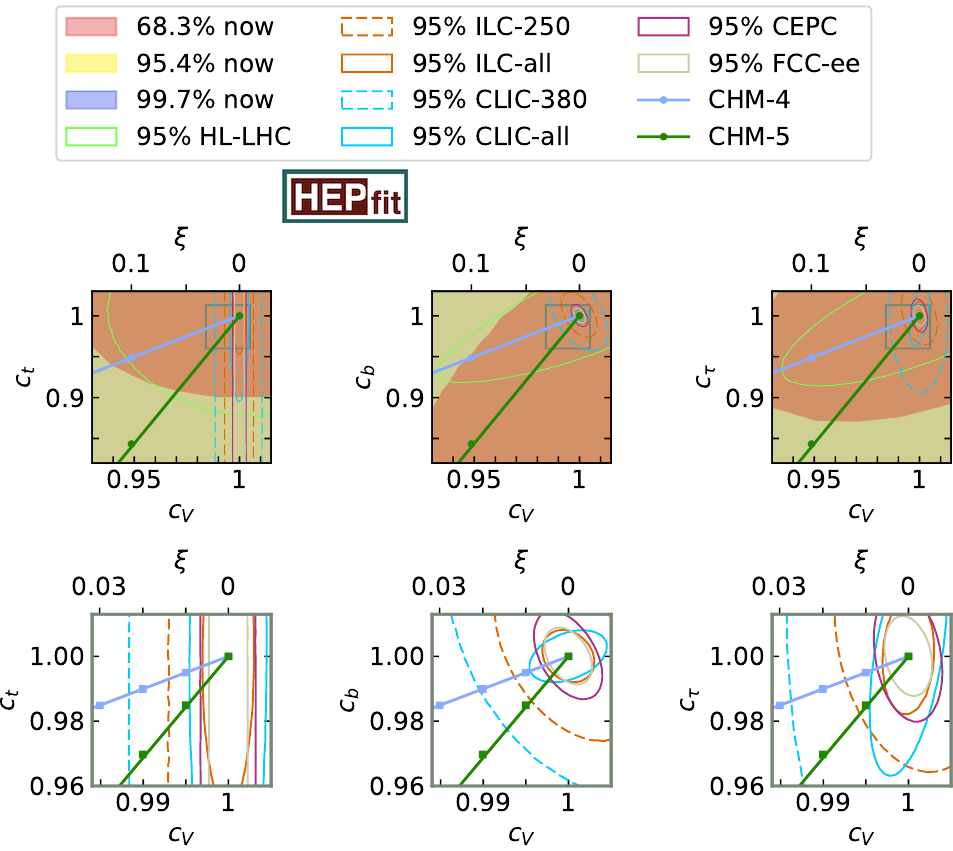
Figure 8 . Magni(cid:12)cation of the c vs. c V planes from (cid:12)gure 6, together with the lines corresponding to the two composite Higgs scenarios discussed in the text. In the top row, we show enlarged regions for the third generation fermion couplings, in which the dots are equivalent to the ones in (cid:12)gure 7 for (cid:24) =0, 0.1 in decreasing c V direction. The bottom row zooms in on the grey boxes of the top row. Here the squares mark the points (cid:24) =0, 0.01, 0.02,